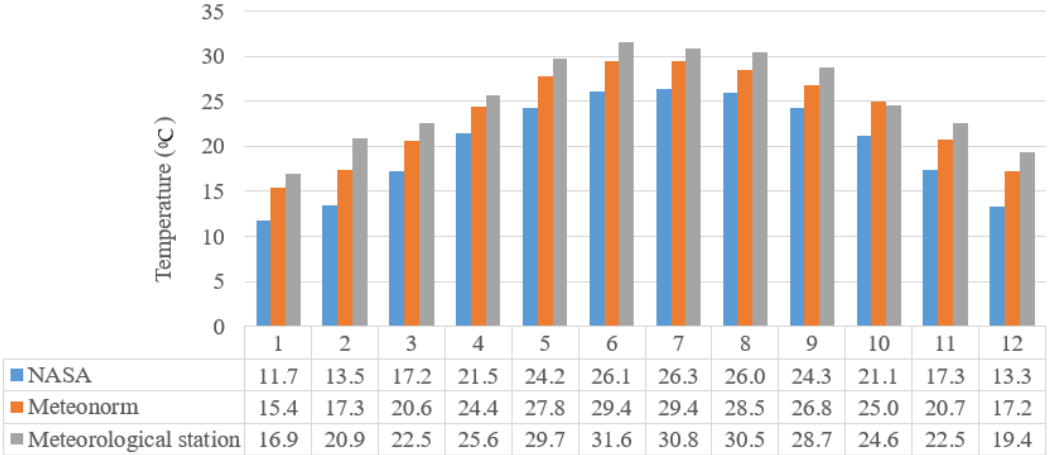
Figure 15. Actual ambient temperature data versus temperature data of NASA and Meteonorm. Table 5. Comparison parameters of solar power stations in Hanoi city, Vietnam.